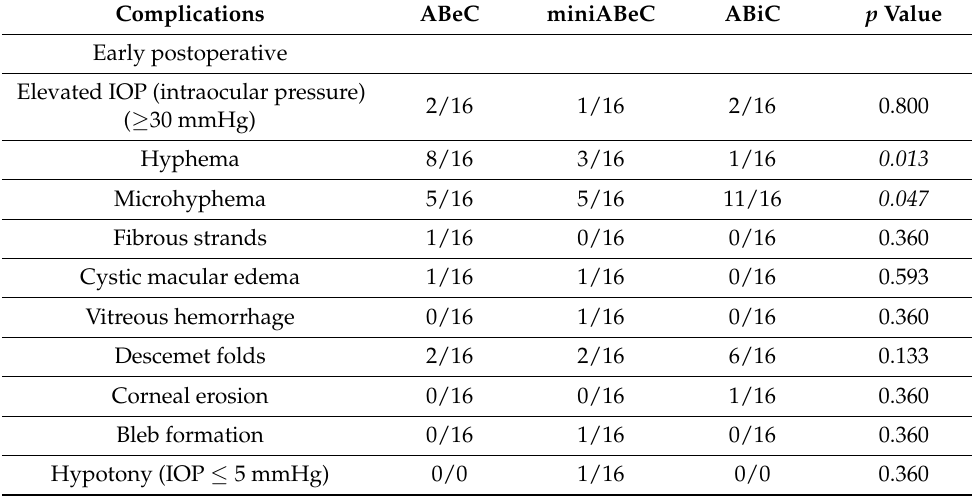
Table 4. Evaluation of surgical and postsurgical complications with the aid of the Chi-square test. Italicized values indicate p <